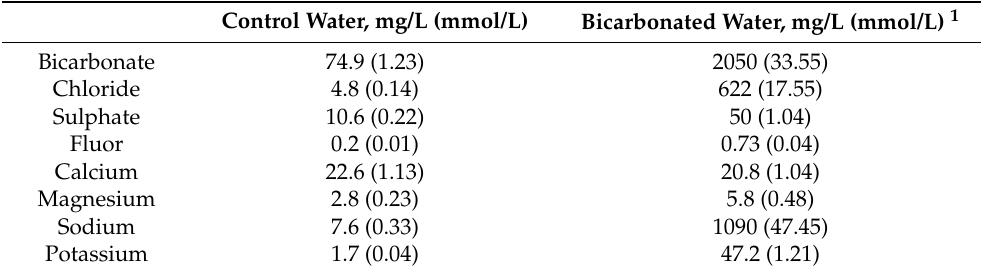
Table 1. Composition of the mineral waters employed in the